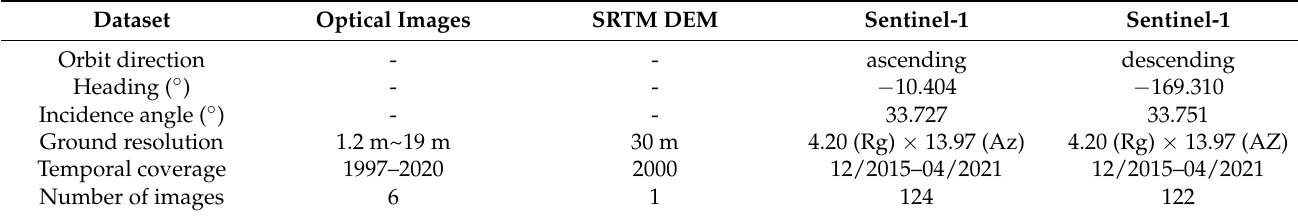
Table 1. Details of the datasets used in this